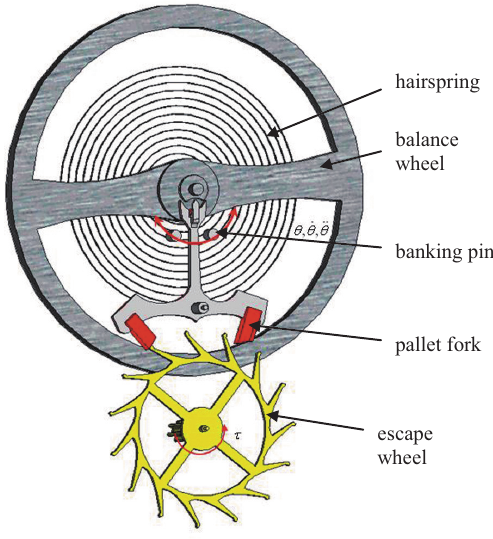
Fig. 1. Illustration of the Swiss lever